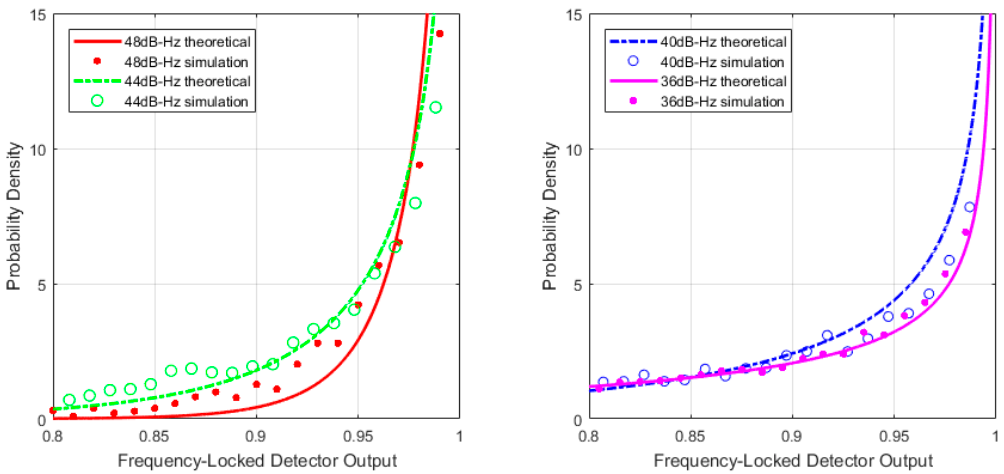
Figure 2. Probability density function (PDF) of theoretical and simulation under high C / N 0 ( T = 1 ms, M = 1).